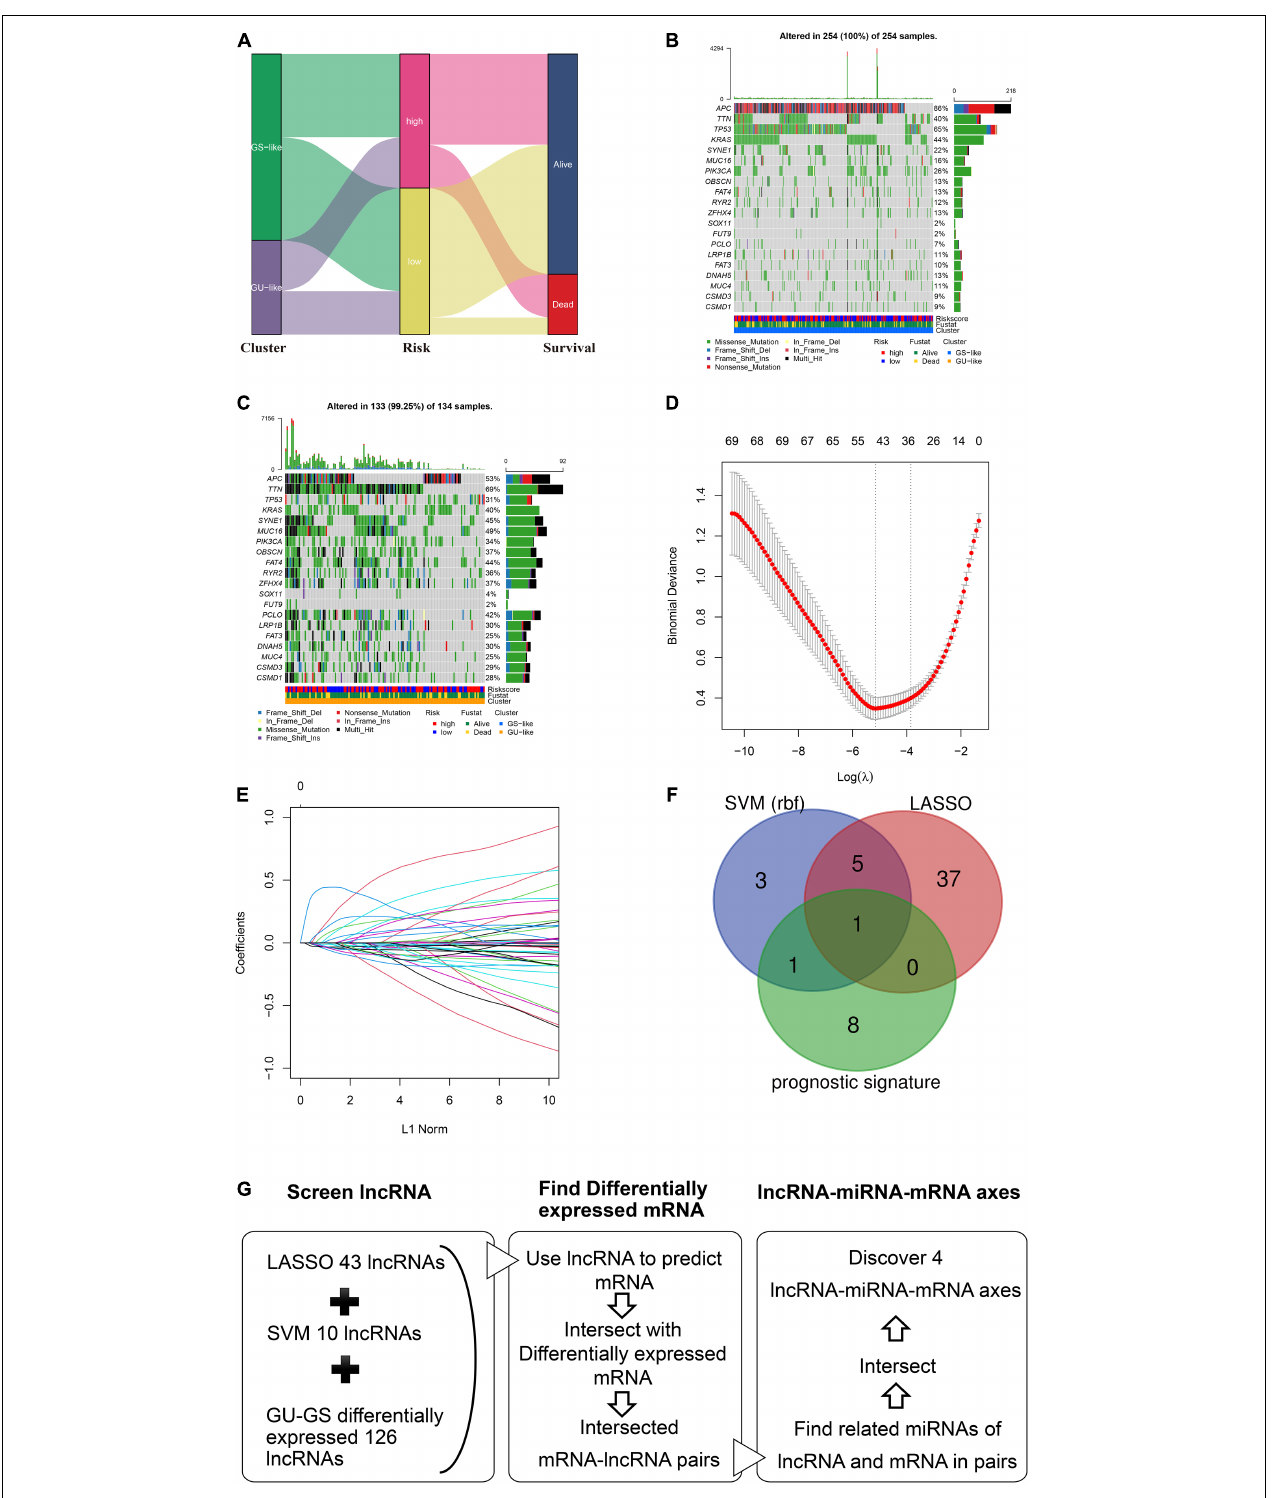
FIGURE 4 | Analysis of mutation profile and identification of hub-lncRNAs in genome stable (GS)- and genome unstable (GU)-like clusters. (A) Sankey plot of the relationship among GS- and GU-like clusters, risk groups, and survival status. The mutation profile of GS-like cluster (B) and GU-like cluster (C) . (D) The selection of λ in least absolute shrinkage and selection operator regression. (E) The selection of L1 norm in LASSO regression. (F) The Venn plot of hub-lncRNA in SVM (support vector machine), LASSO, or prognostic signature. (G) Screening process of the lncRNA, miRNA, mRNA included in the ceRNA network.